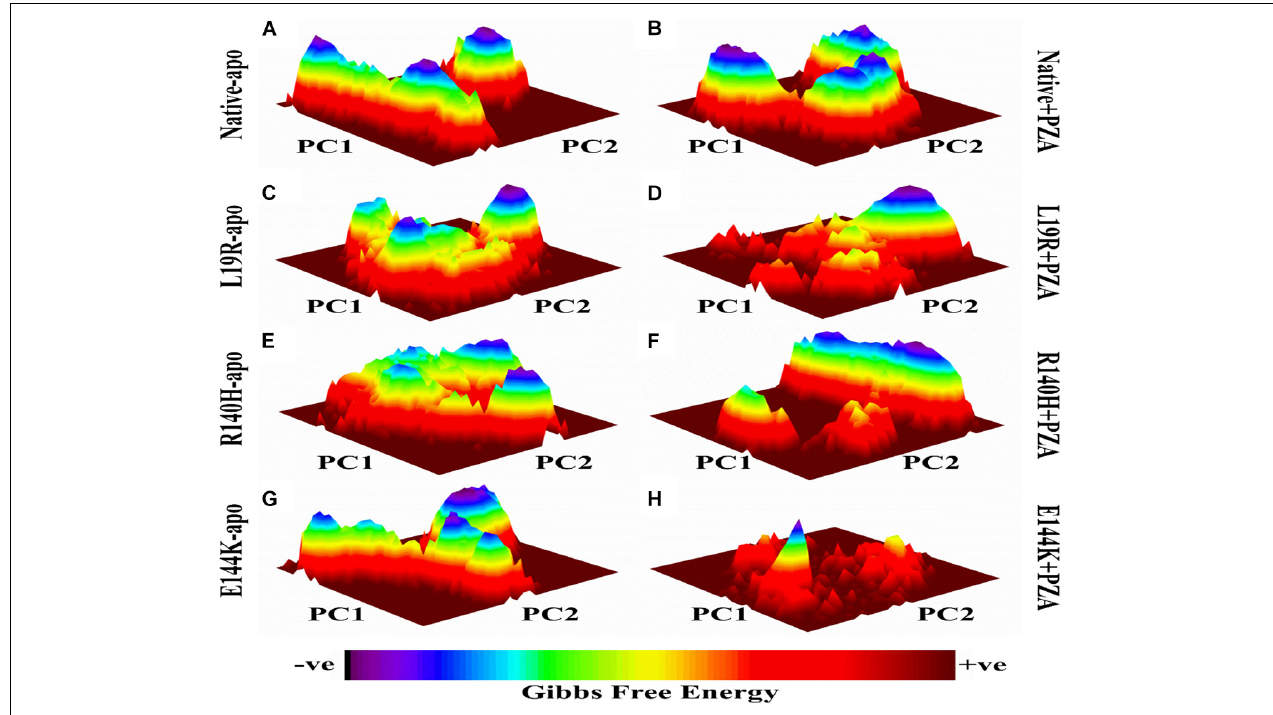
FIGURE 2 | Gibbs free energy of PZase and MTs (L19R, R140H, and E144K) in apo and complex state with PZA. (A,B) GFE peaks of WT apo and complex with PZA. (C,E,F) MTs apo. (D,F,H) MTs complex with PZA. GFE plots of WT and MTs shows a significant difference in stability states behind mutations involved in PZA resistance (Khan, 2019).